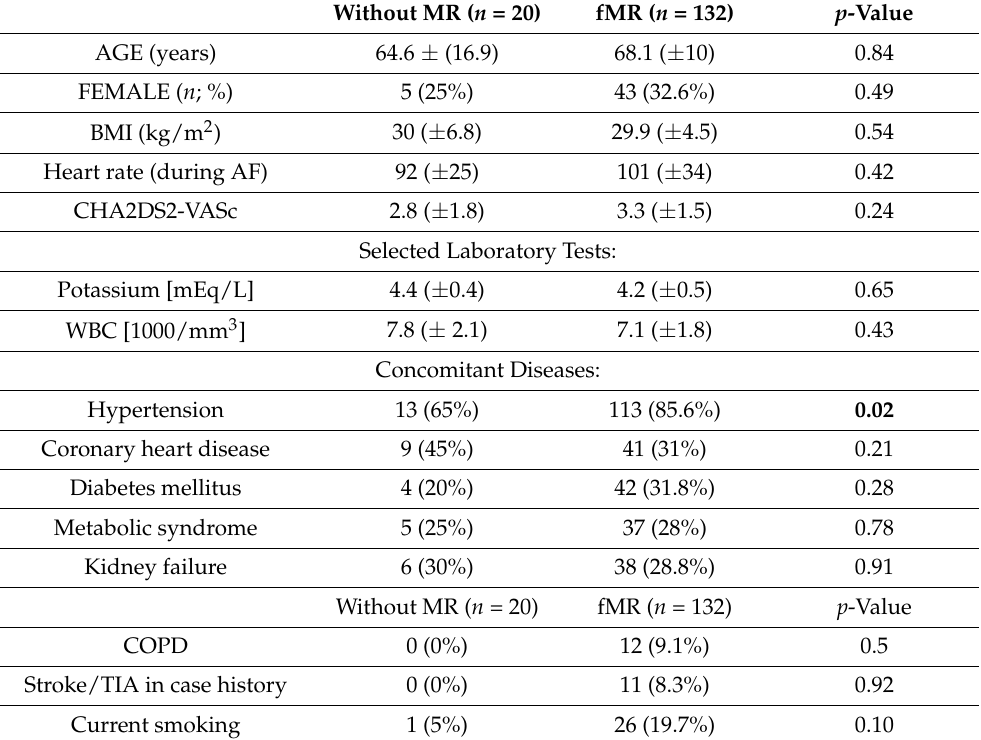
Table 1. Baseline characteristics, comorbidities and risk factors comparison between groups of patients without MR and